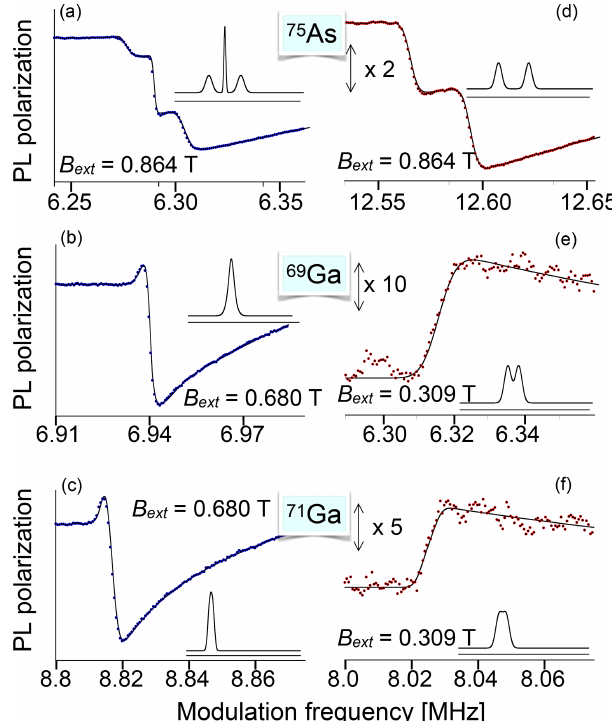
Figure 31. Spectra of single- and double-quantum transitions in GaAs, measured by modulated optical excitation. (a, b, c) The po- larization of the laser beam was modulated for (d, e, f) the ampli- tude. It therefore excites directly the (cid:49)m = ± 2